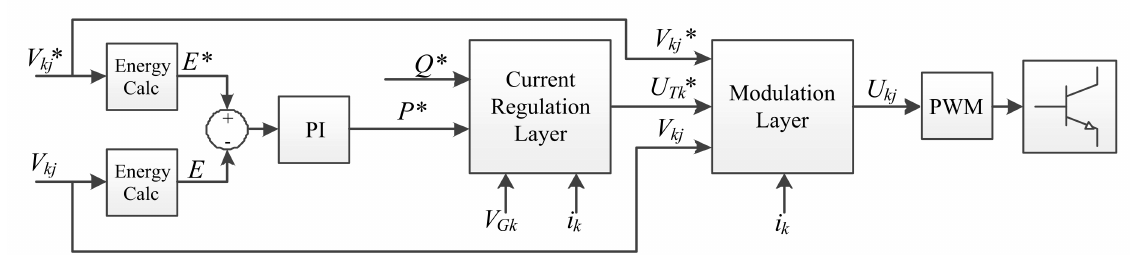
Figure 3. General control scheme. The proposed upgrade is applied to the balancing method in the modulation